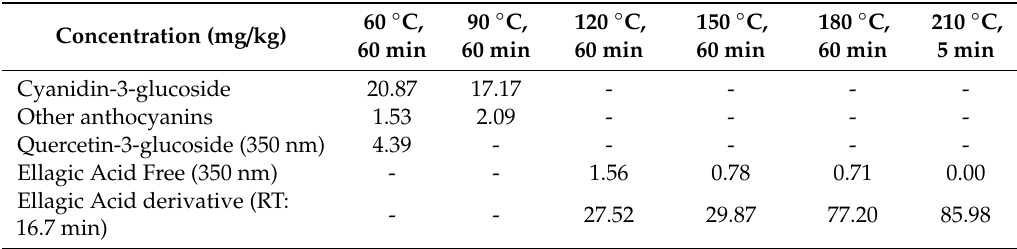
Table 4. Concentration of individual phenolic compounds obtained after each hydrothermal treatment. Concentration (mg/kg)